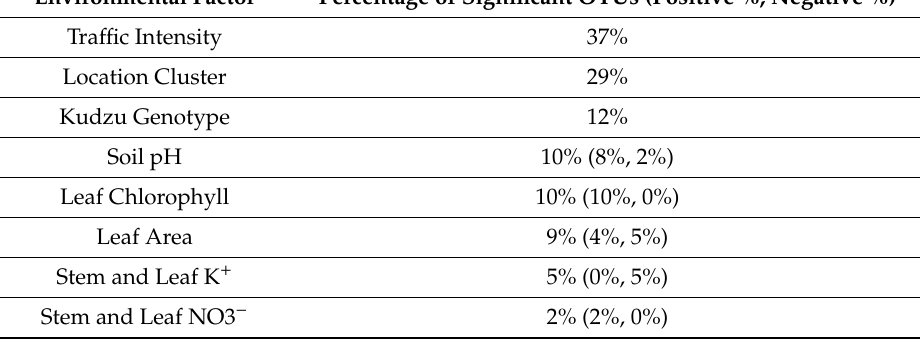
Percentage of the 100 most abundant OTUs that were significantly responsive to physio-biochemical or geographic measurements (Regression or ANOVA). Where analyses are regression based, the percentage of positive and negative relationships are given parenthetically. Results are presented ranked by the number of OTUs responsive to measurements. Full test statistics are presented in Table